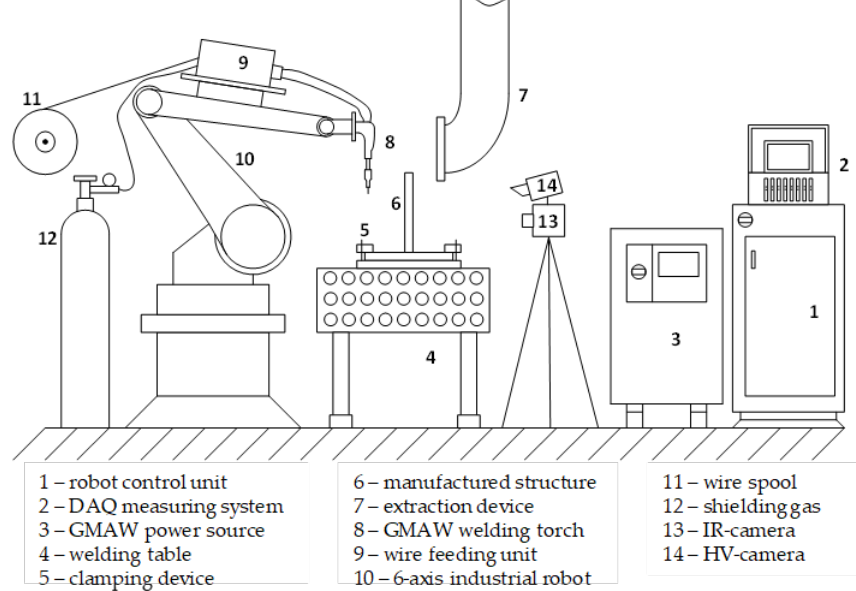
Figure 2. Experimental setup of the wire arc additive manufacturing (WAAM) process.